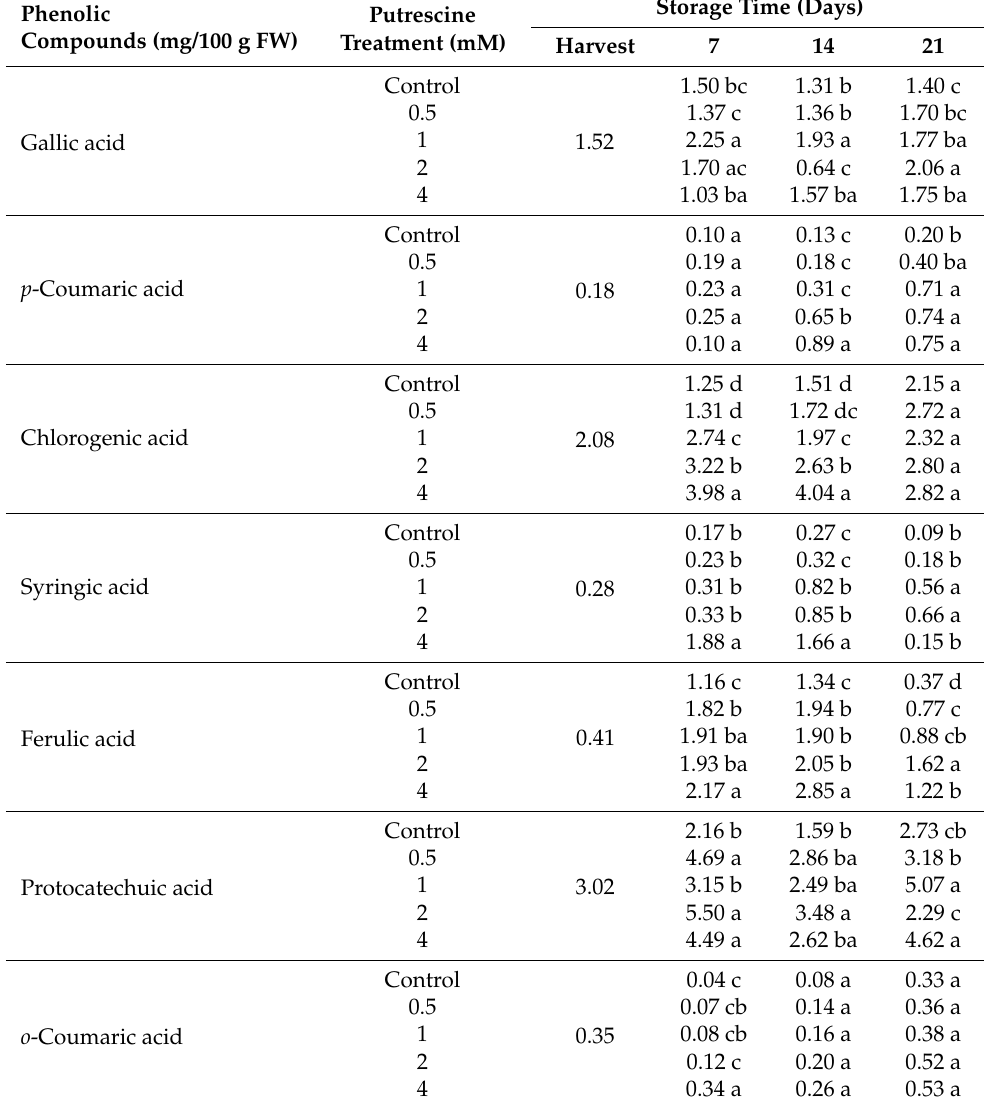
Table 1. Effect of putrescine treatment on phenolic acids of fig fruit during cold